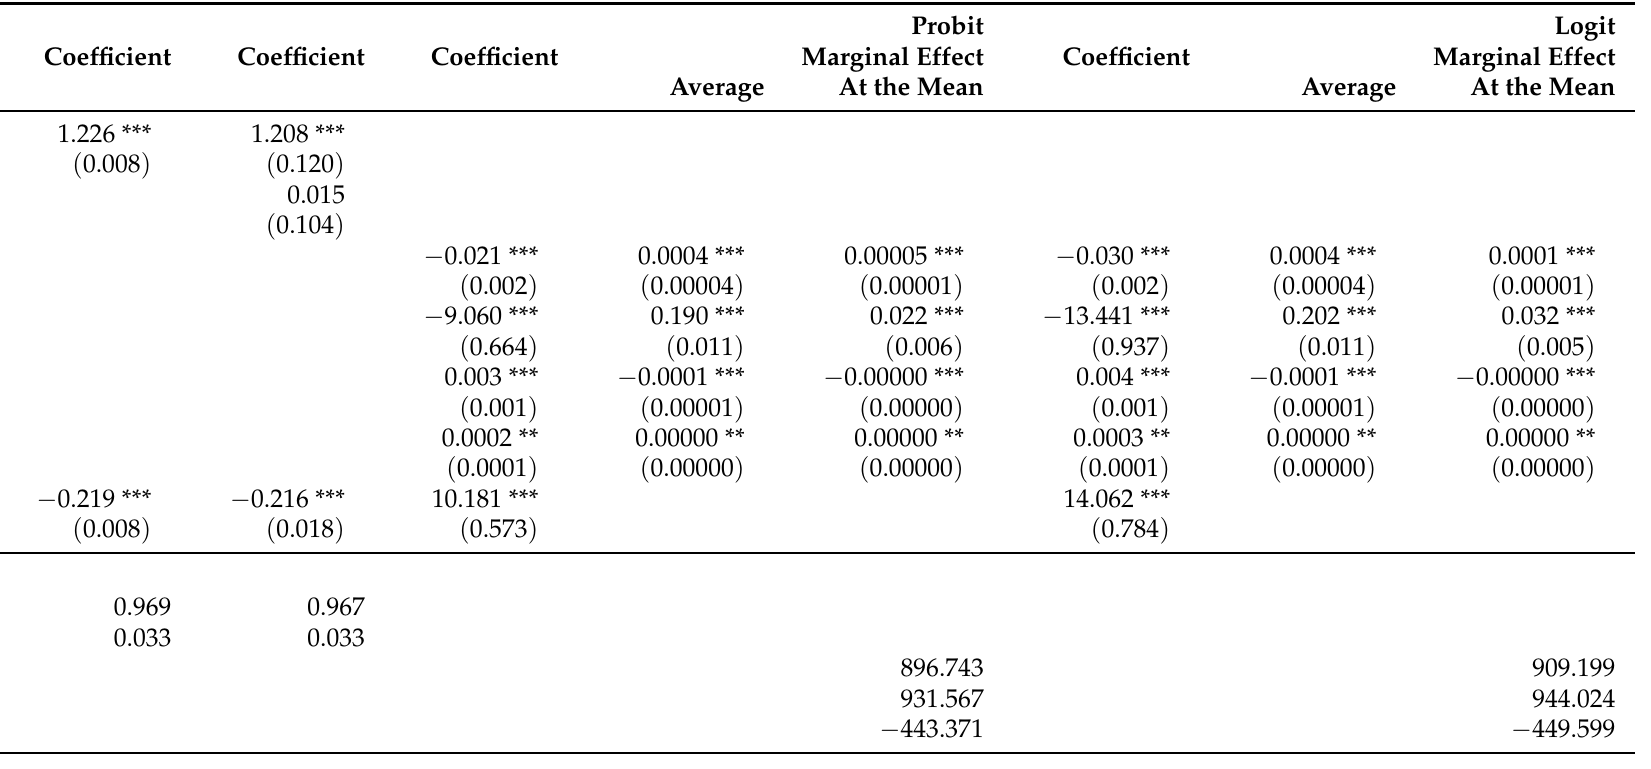
Table 7. Second-step outcomes with continual learning